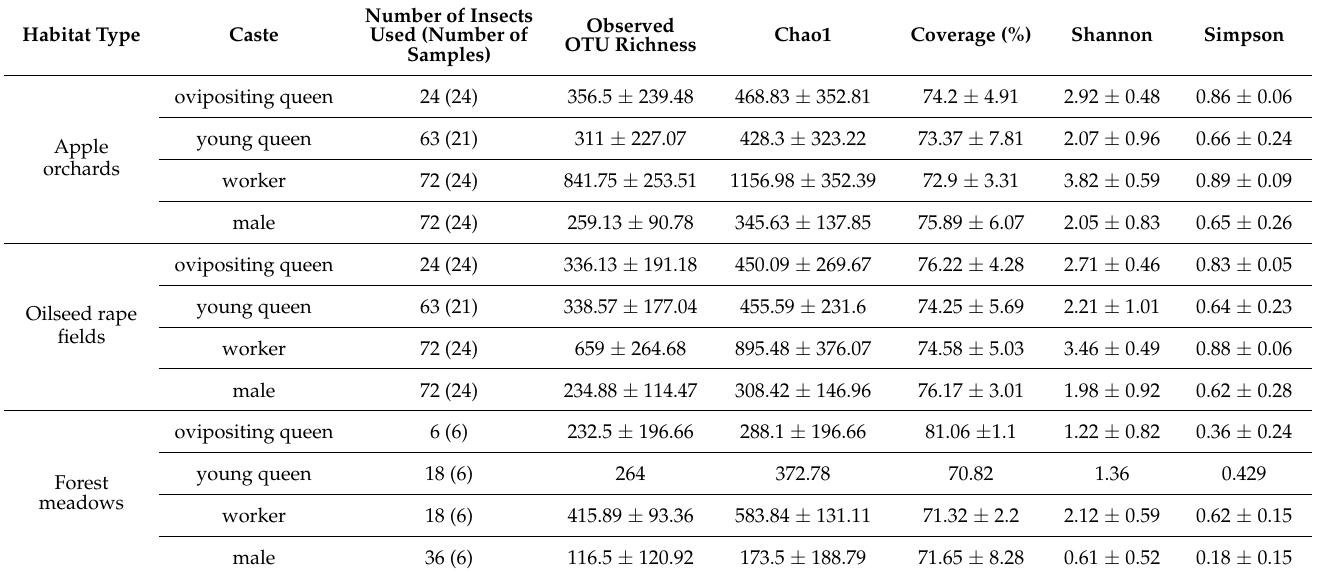
Table 1. Mean diversity measures ( ± standard deviation) of gut bacterial communities in Bombus terrestris